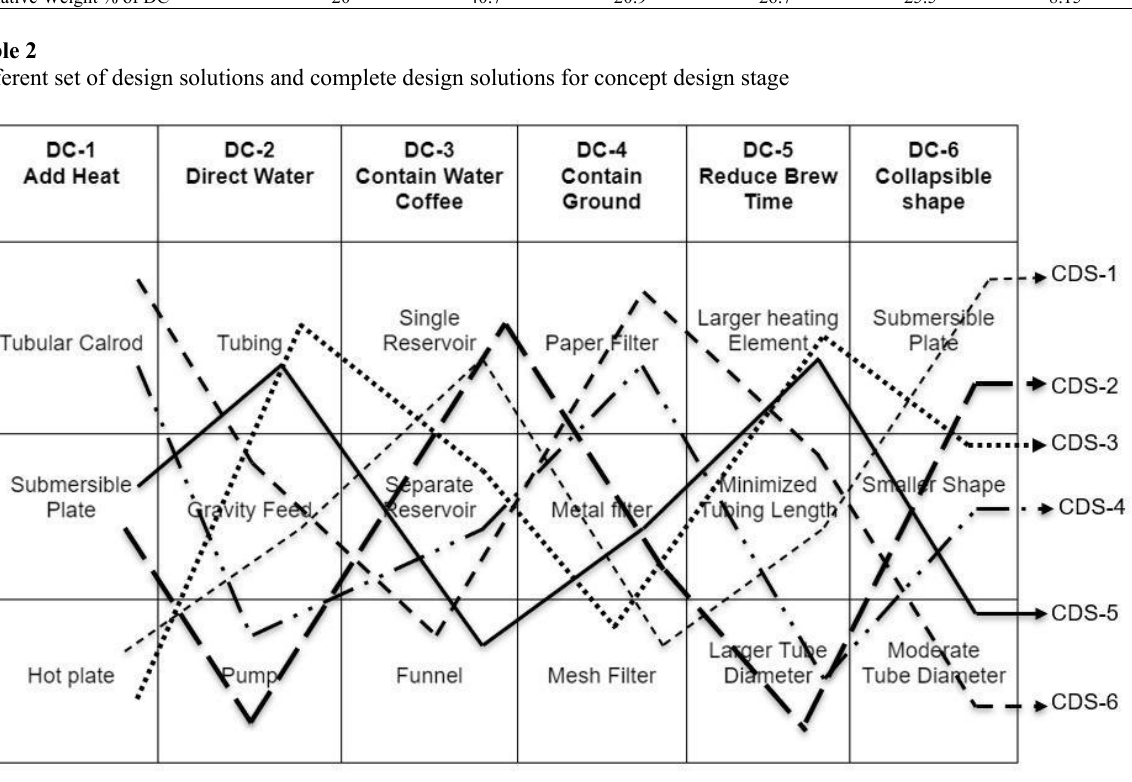
Design Characteristics (DC)